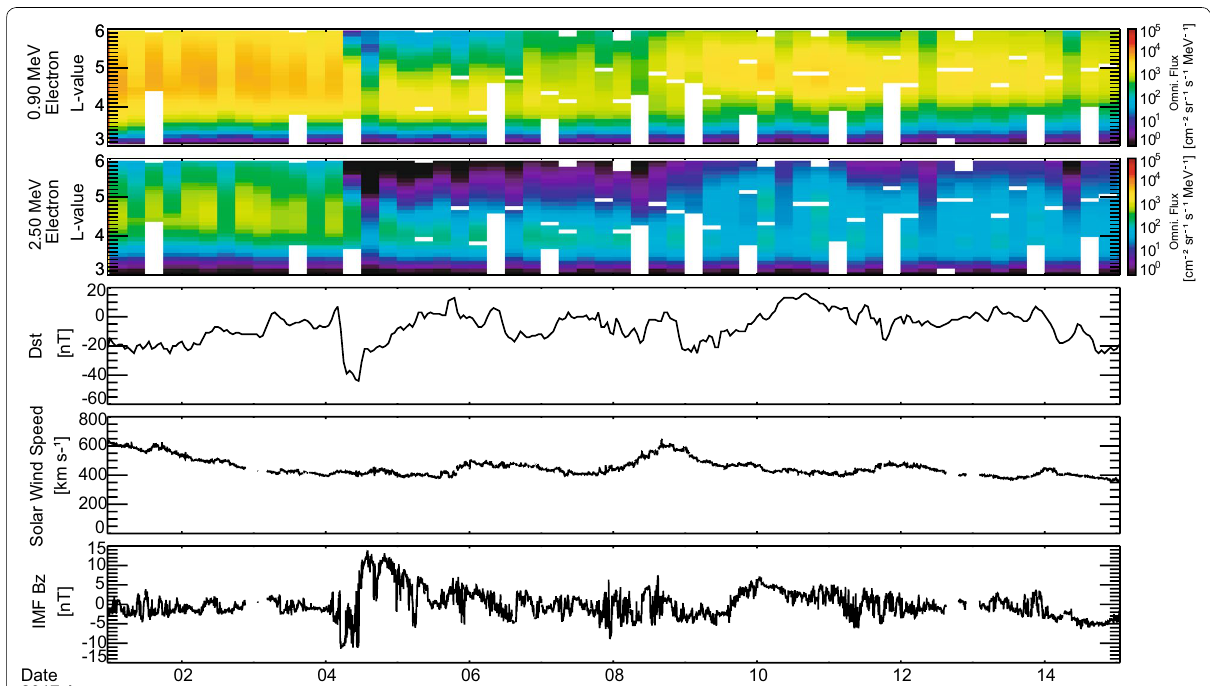
Fig. 10 Time and spatial variations of energetic electron fluxes during the 14-day interval after April 1, 2017, for 0.9 MeV (top panel) and 2.5 MeV (second panel) observed by XEP. The Dst index (third panel), solar wind speed (fourth panel) and IMF B z (bottom panel) are also